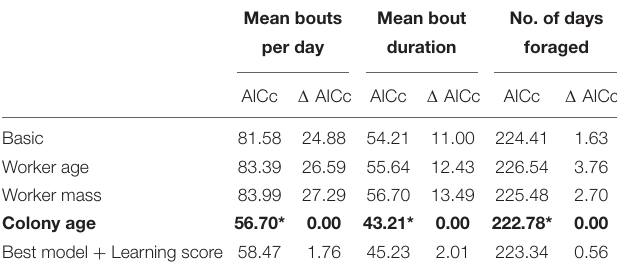
correlated (Pearson’s Correlation, r = 0.81, n = 7, p = 0.03), but